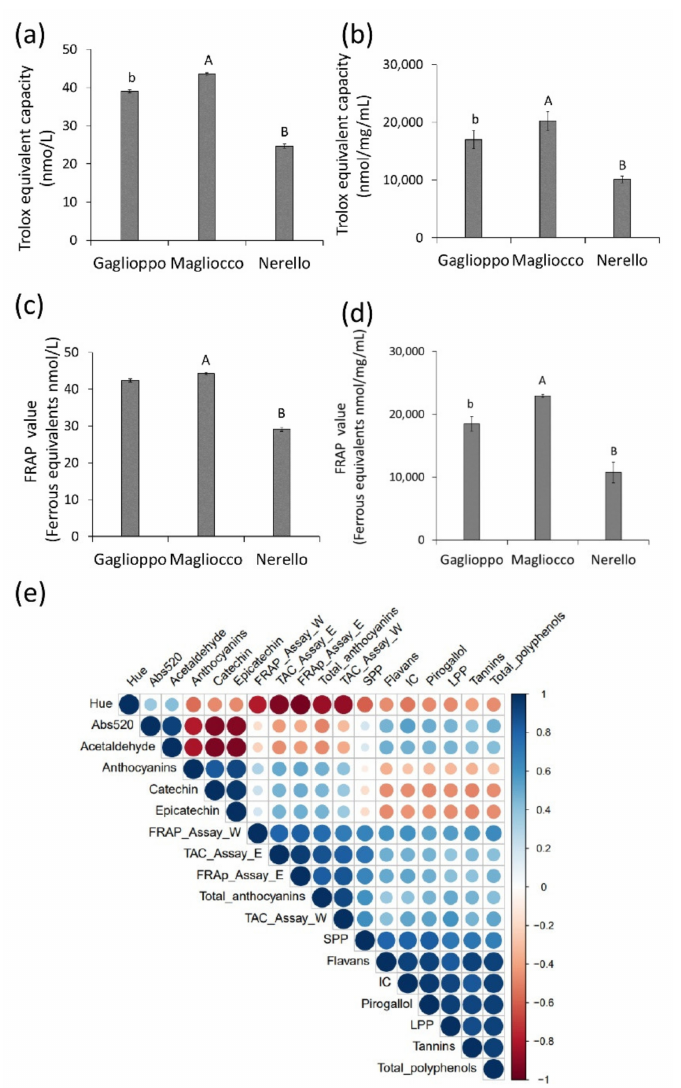
Figure 1. Antioxidant potential of red wines and correlation with the polyphenol contents. Total antioxidant activity and ferric reducing power were reported for ( a,c ) whole red wine samples and ( b,d ) lyophilized wine samples of Gaglioppo, Magliocco, and Nerello. Values represent the mean ± SD of n = 3 independent experiments. ( e ) Correlation plot is between the antioxidant activity and the phenolic contents of the wines. Stronger correlations are depicted by larger circles, with shades of blue representing positive correlations and shades of red representing negative correlations. Ab, p < 0.05 and AB, p <